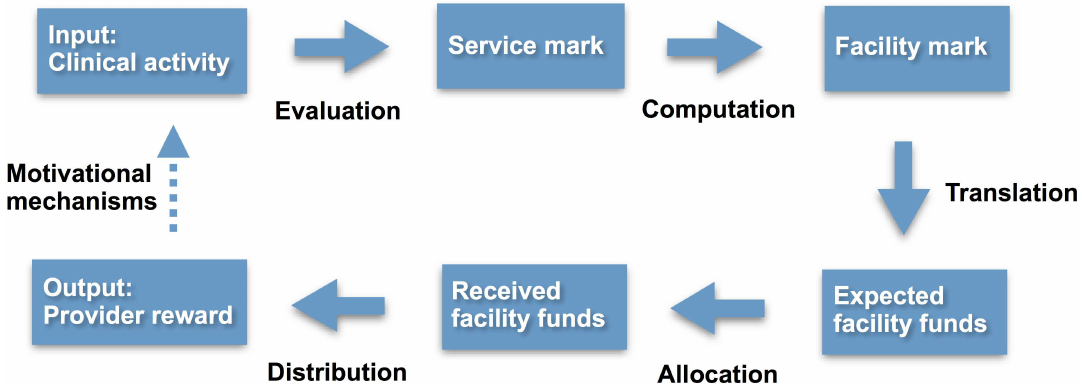
Fig 3. Processfrom clinical activity to provider